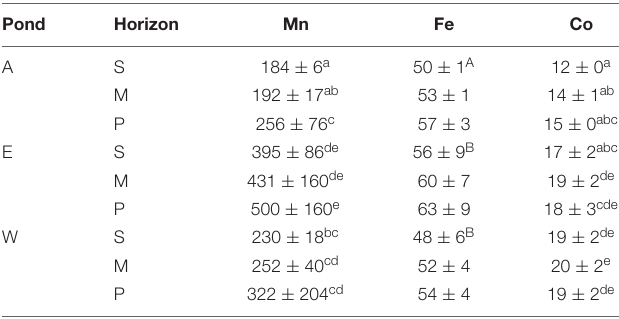
Upper-case letters indicate the groups of ponds differentiated by the two-way ANOVA. Lower case letters show the groups of ponds differentiated by Dunn’s comparison test after a significant non-parametric Kruskal–Wallis test.